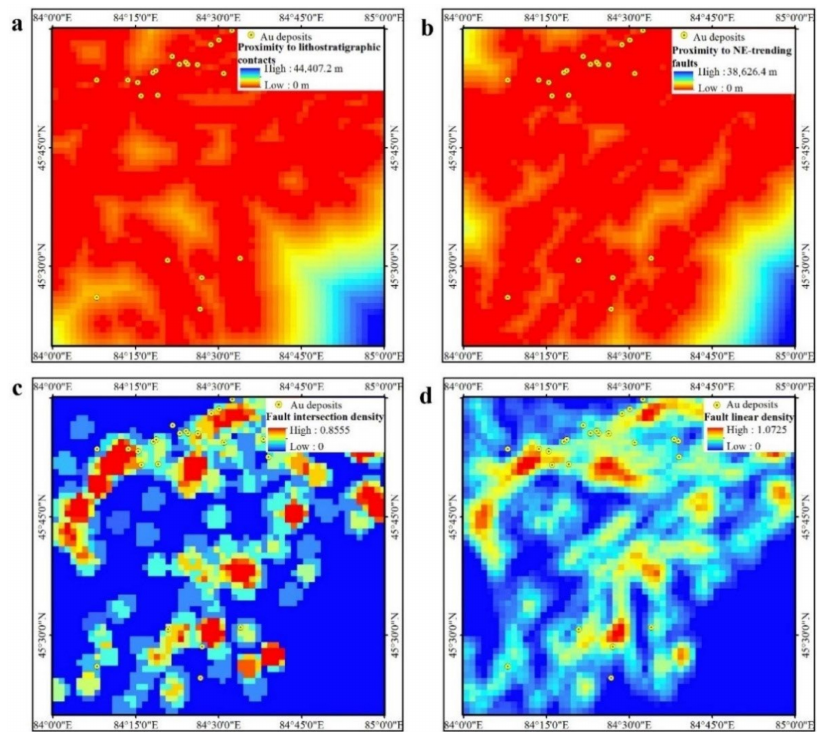
Figure 3. Derived geo-evidential layers: ( a ) proximity to lithostratigraphic contacts; ( b ) proximity to NE-trending faults; ( c ) fault intersection density; ( d ) fault linear density.